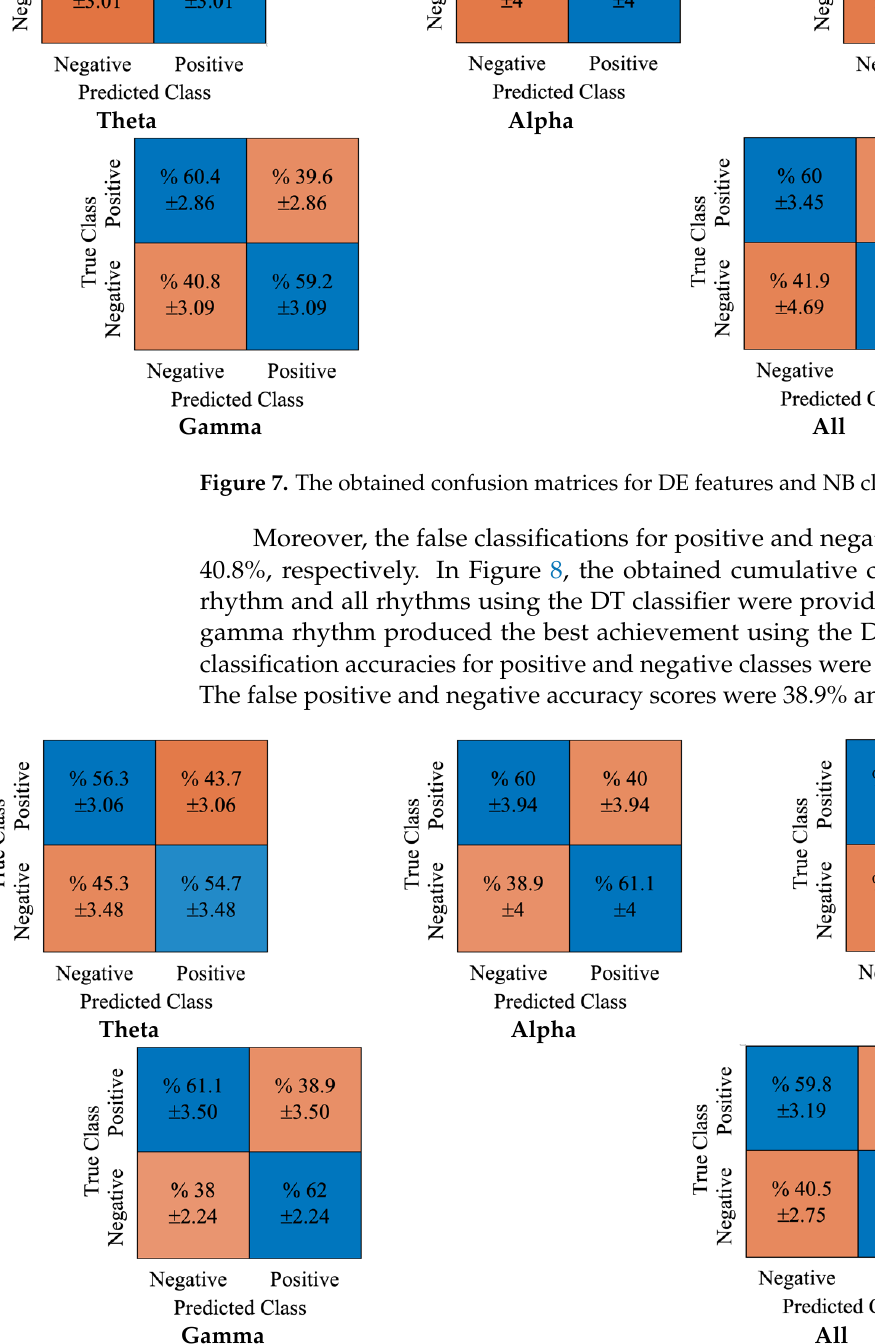
Figure 8. The obtained confusion matrices for DE features and DT classifier. Figure 9 shows the obtained cumulative confusion matrices for each rhythm and all rhythms using LR classifier. Similar to the previous results, the gamma rhythm produced the best achievement with this classifier. The true positive and true negative rates obtained were 63.5% and 64.6%, respectively. The false positive and negative accuracy scores ob- tained were 36.5% and 35.4%, respectively. Theta All Figure 9. The obtained confusion matrices for DE features and LR classifier.